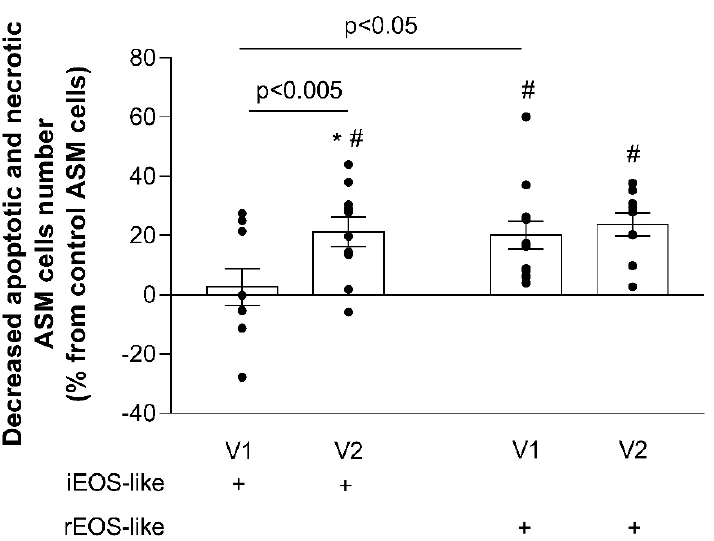
Figure 8. Effect of the bronchial allergen challenge on rEOS-like and iEOS-like cells promoted ASM cell apoptosis. AA, allergic asthma; V1, visit 1 (before the bronchial allergen challenge); V2, visit 2 (24 h after the bronchial allergen challenge). Results from independent experiments of AA, n = 13. # p < 0.05 compared with control ASM cells without co-culturing with eosinophils; * p < 0.05 compared with the HS group. Statistical analysis: between investigated groups, Mann–Whitney two-sided U-test; within one study group, comparing each point of the subject individually, Wilcoxon matched-pair, signed-rank, two-sided